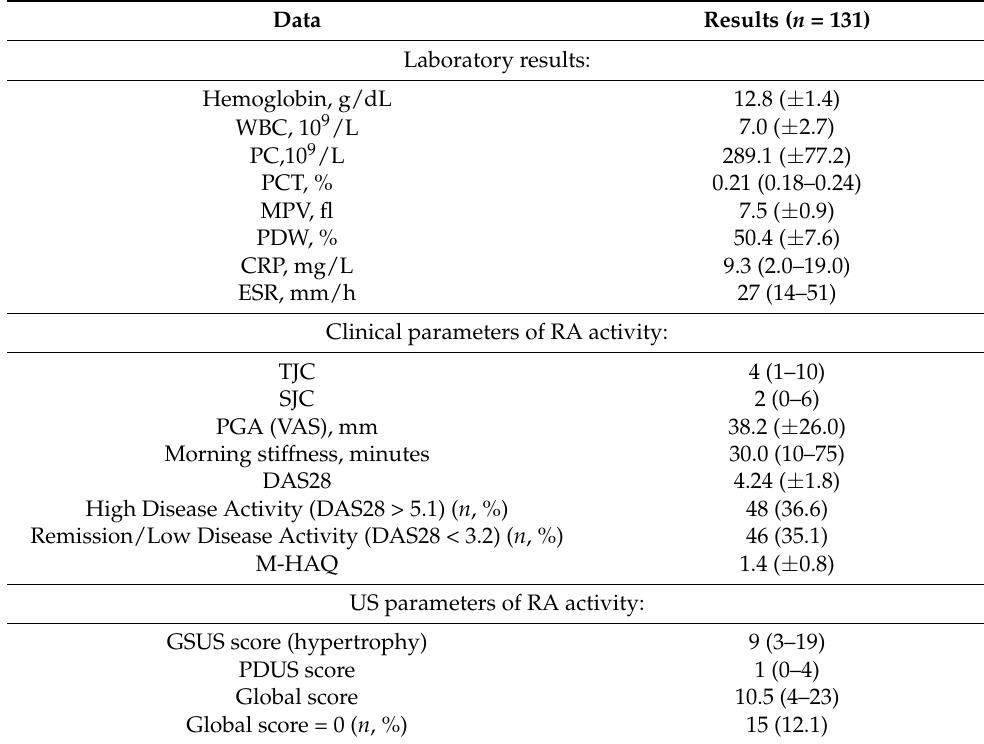
Table 2. Laboratory, clinical and US parameters in RA